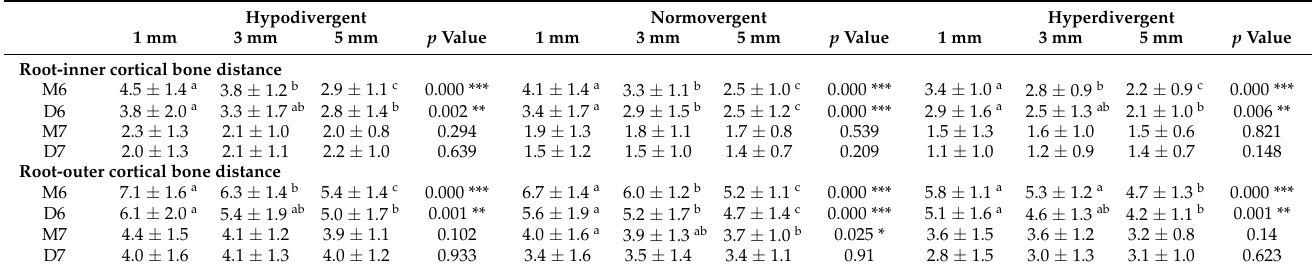
Table 4. Mean distance ( ± standard deviation) between the mandibular molar roots and the lingual cortical bone according to the root